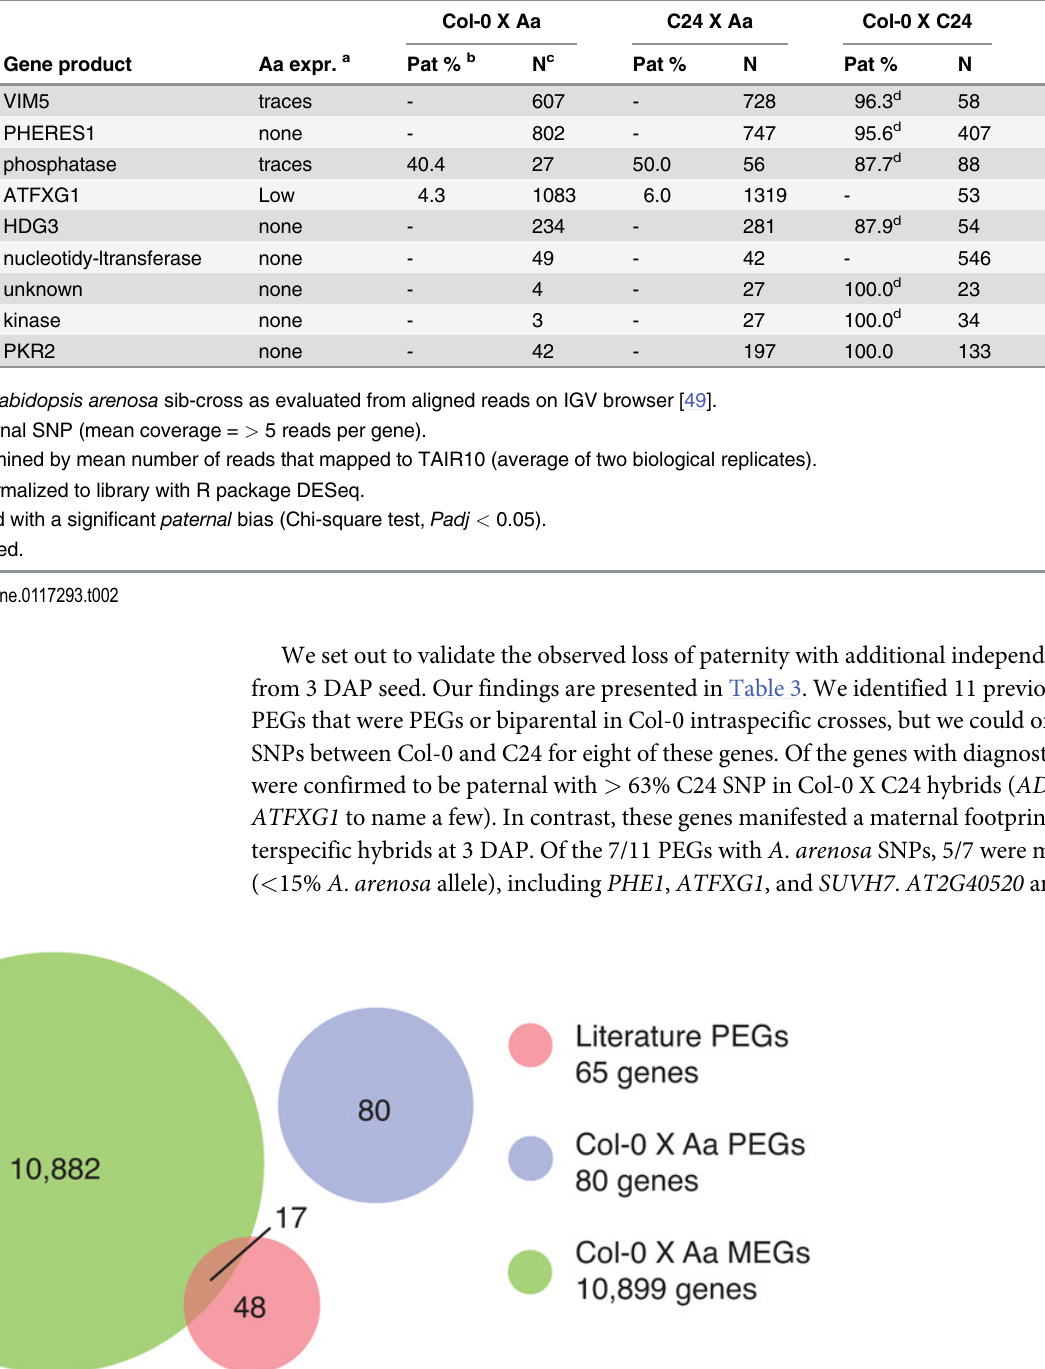
Table 2. Abnormal Paternally Expressed Genes (PEGs).